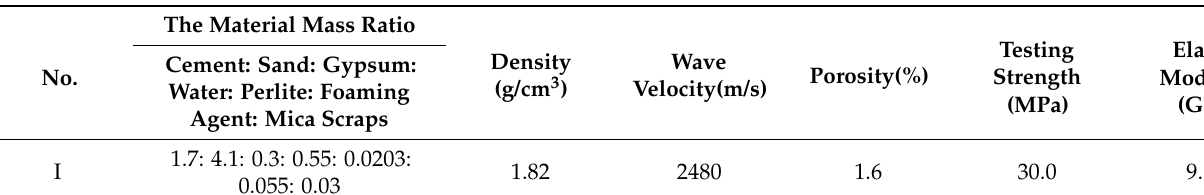
Figure 12. The HPAB experimental system: ( a ) schematic diagram; ( b ) physical picture.